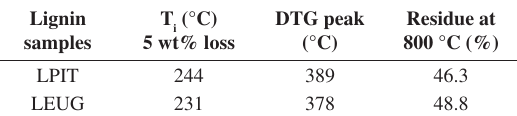
Table 1. Thermal degradation temperatures, DTG peak and % residue for the lignins under study. Lignin samples